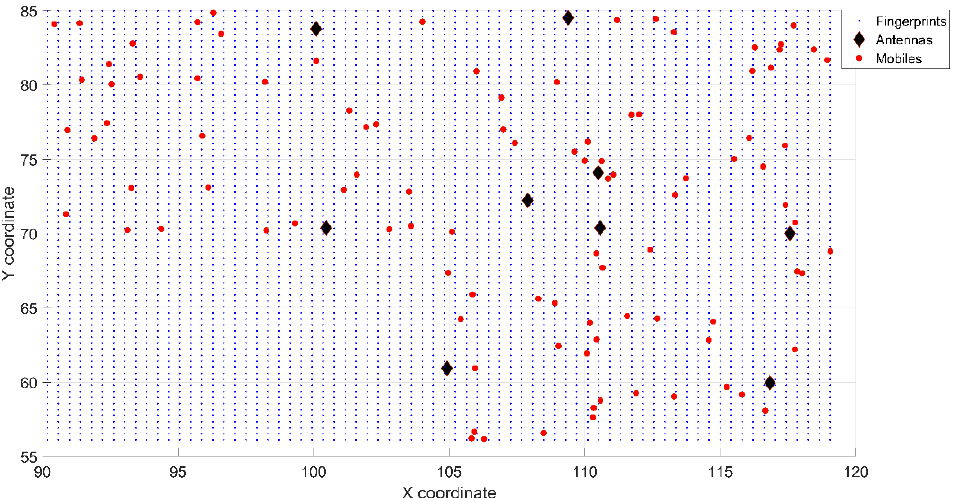
Figure 9. 2D view of the University Polytechnic of Madrid simulation area: A section of 36 × 36 m containing 1296 fingerprints, 99 mobiles to locate and 9 APs.